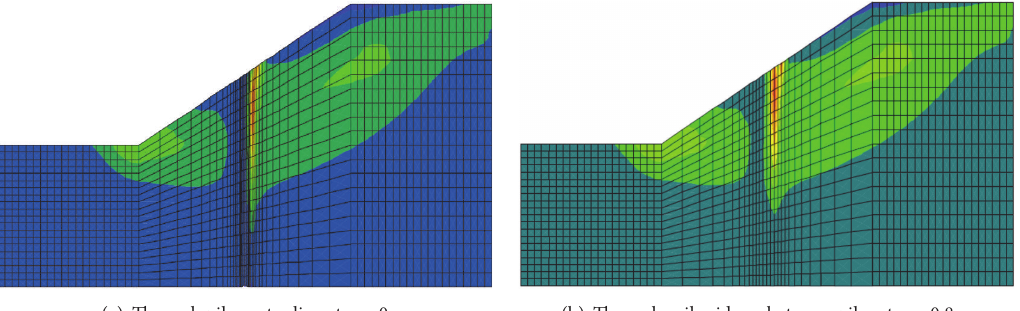
Figure 13: Failure mode of a slope with piles 𝐶 = 0 at different sections.